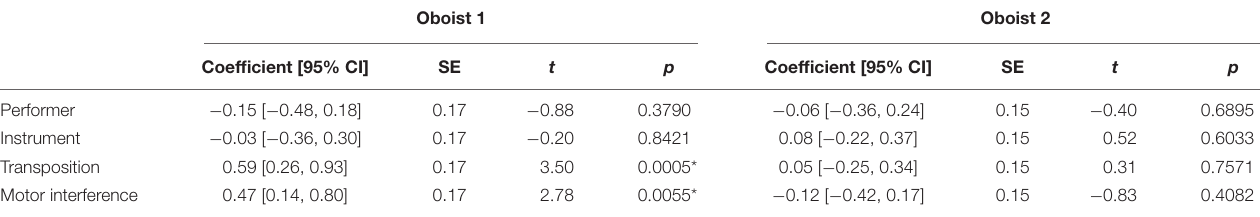
TABLE 3 | Main results from ordinal logistic regression of semitone off values on the four condition variables: performer (self vs. other), instrument (own oboe vs. other oboe), transposition (original vs. pitch-shifted), and motor interference (no interference vs. motor interference), separately for Oboist 1 and Oboist 2.